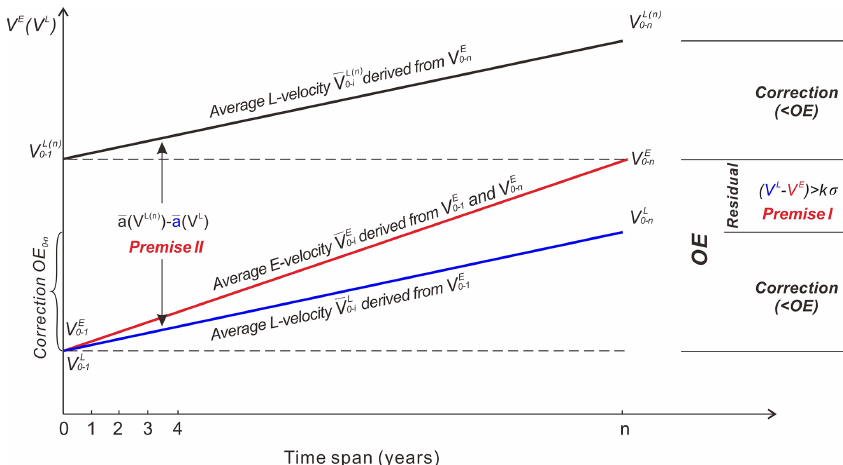
Figure A2. Overestimation correction in case of temporal